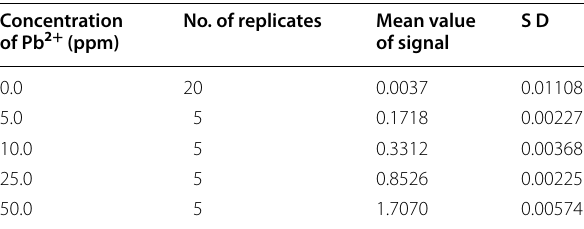
Table 1 The results of AA calibration for